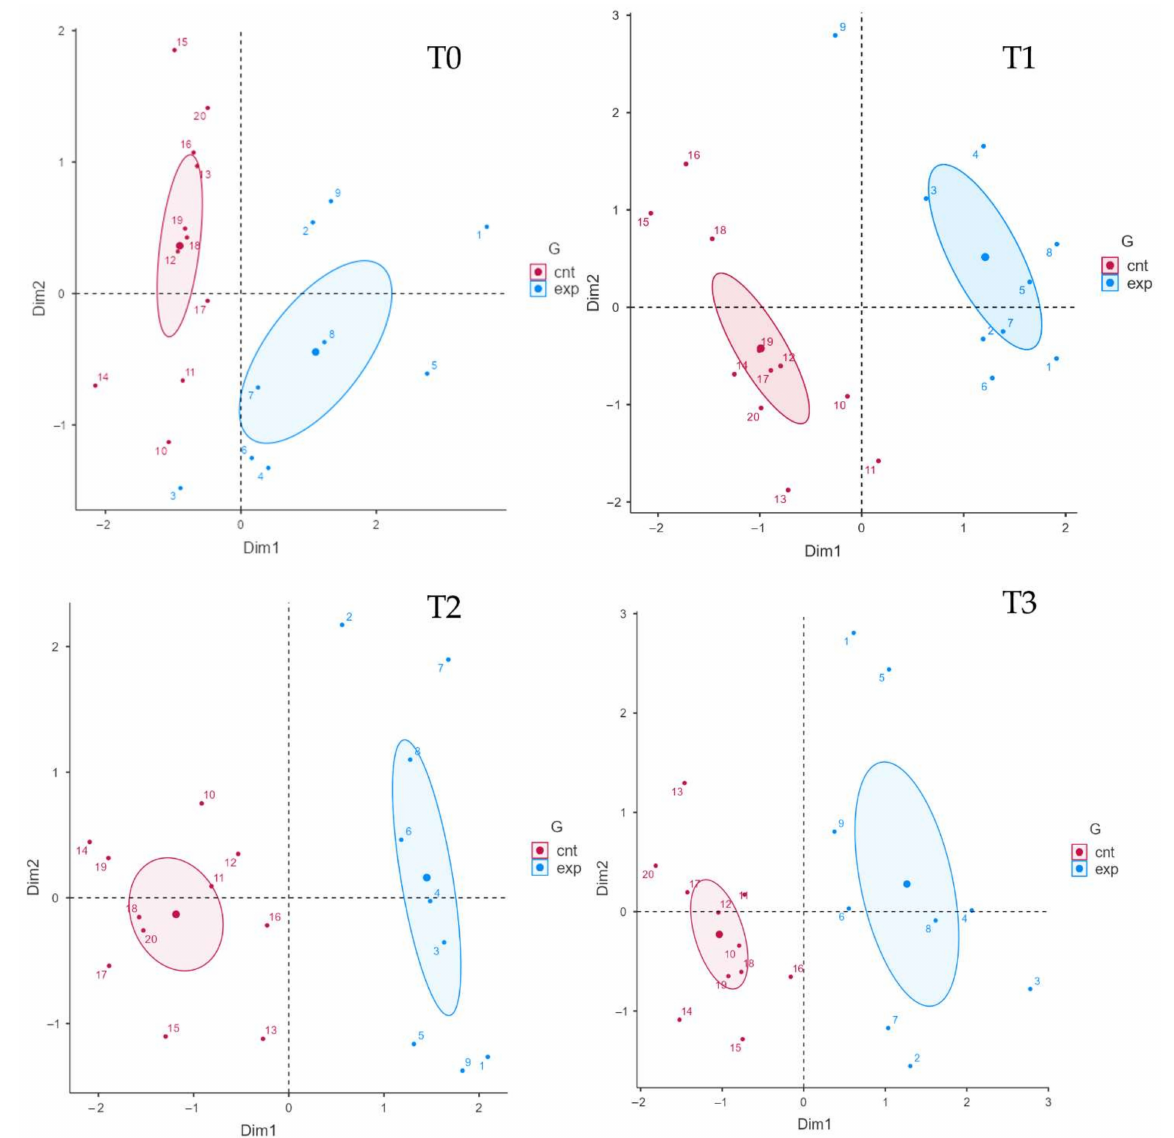
Figure 5. Clustered individual factors map. Each individual is positioned according to the Cartesian axes and thickens in specific clusters that reflect the influences of the dimension and each